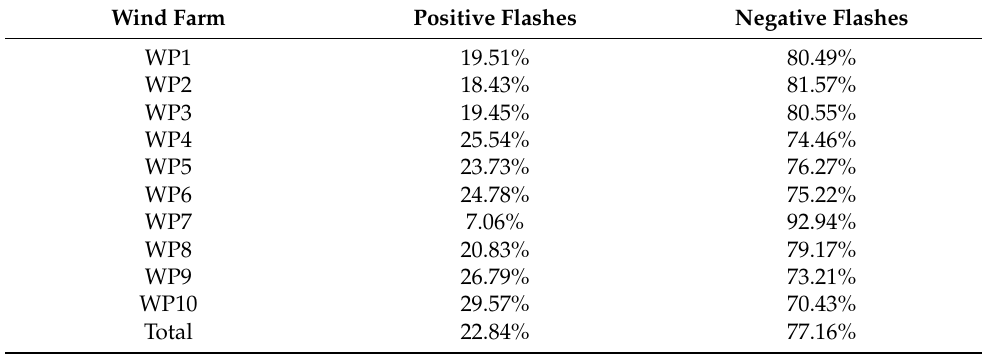
Table A1. Percentage of total lightning flashes for positive and negative ones per wind